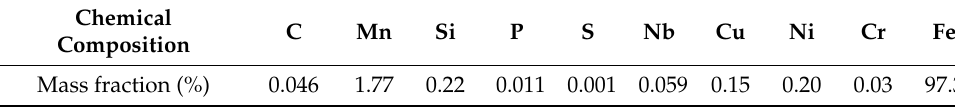
Table 1. Chemical composition of X90 pipeline steel (mass fraction, %).